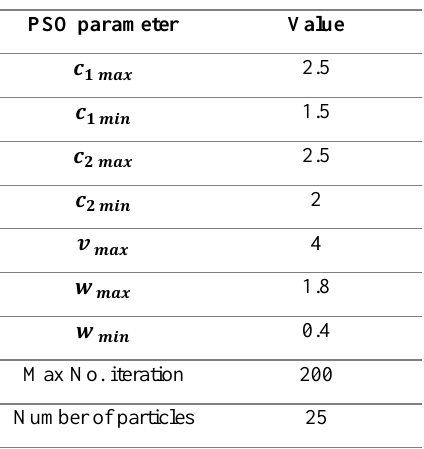
Table 2. Parameter setting of